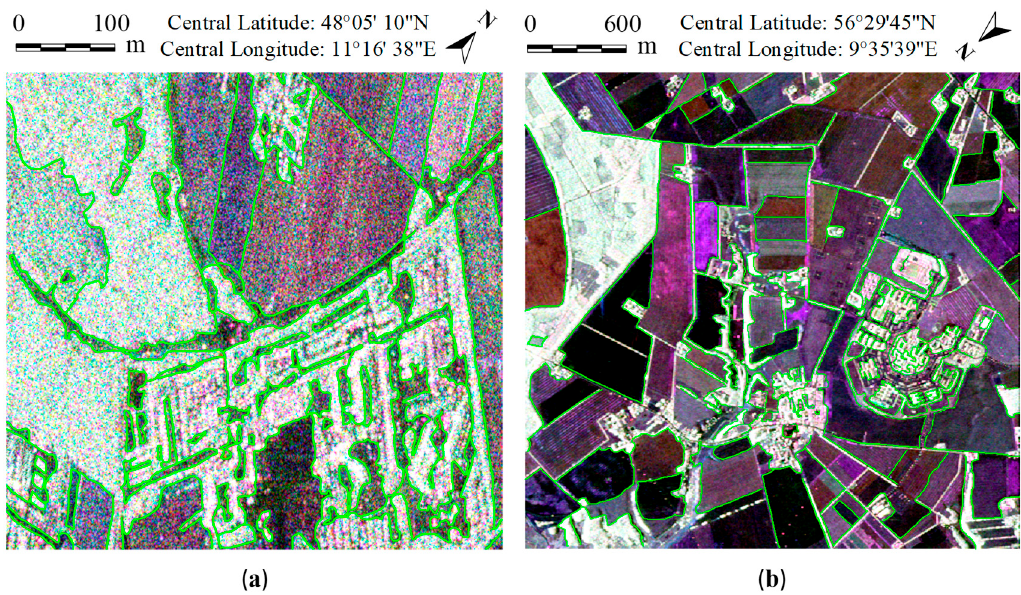
Figure 4. Experimental datasets used in the paper, with the green lines depicting the ground truth: ( a ) ESAR L-band PolSAR image from Oberpfaffenhofen in Germany; ( b ) EMISAR data from Foulum, Denmark.